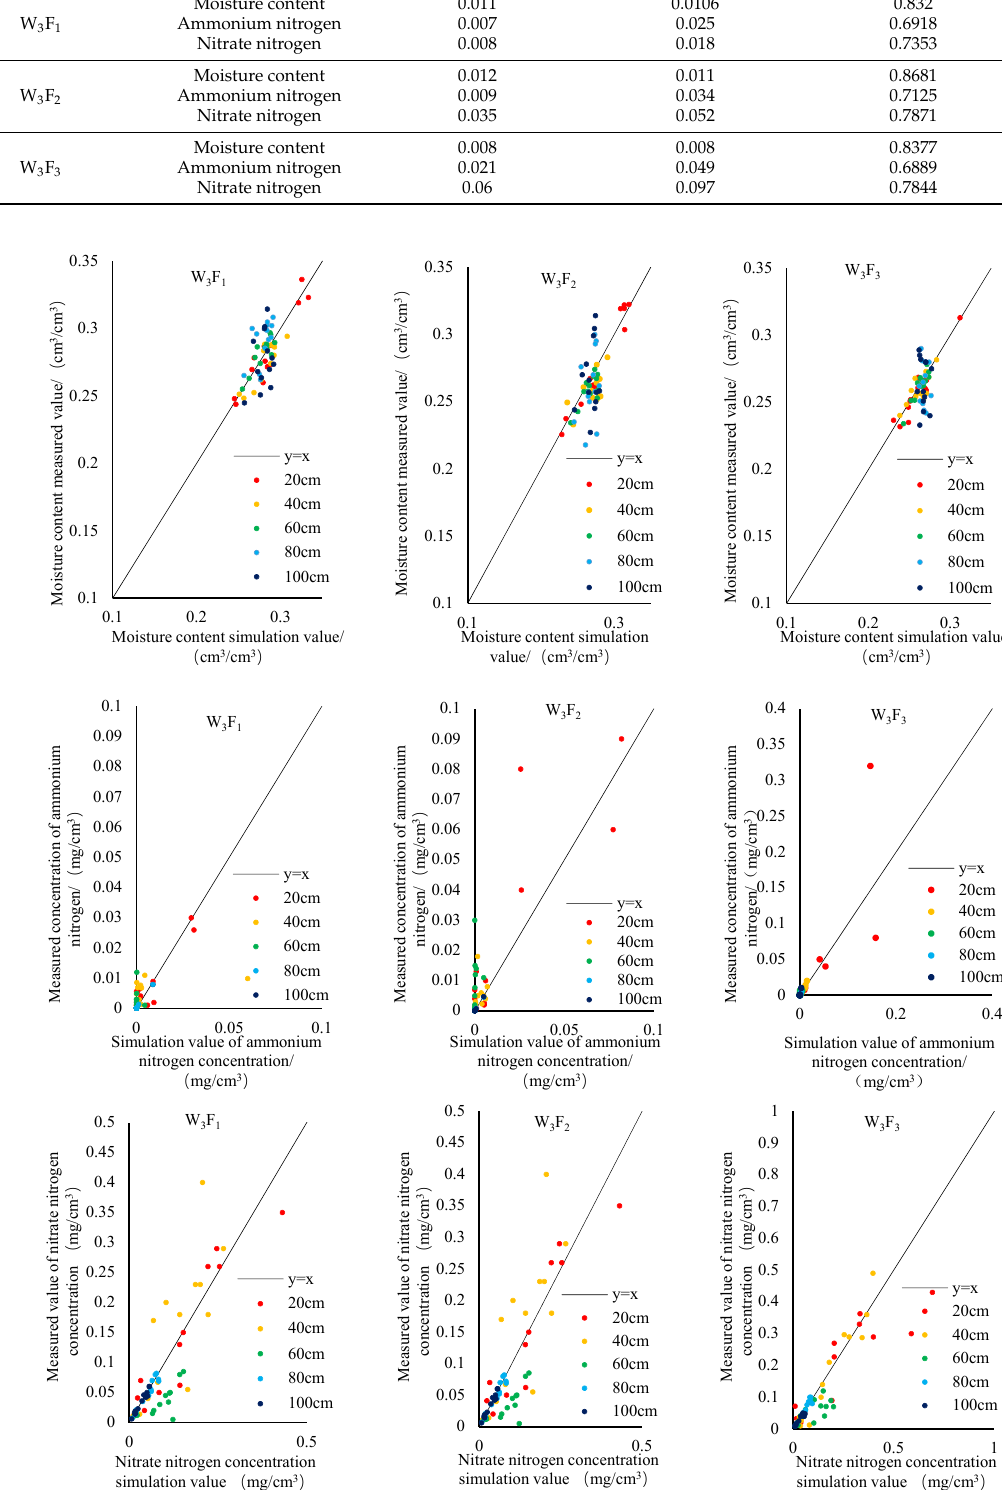
Table 6. Model accuracy was greatest for soil volumetric water content, with R 2 in the horizontal direction > 0.83 and R 2 in the vertical direction > 0.81. The MAE for predicted ammonium nitrogen compared with the measured value was 0.007–0.021 in the horizontal direction and 0.003–0.008 in the vertical direction. The RMSE was 0.025–0.049 in the hori- zontal direction and 0.003–0.023 in the vertical direction. However, R 2 was >0.68 due to the low concentration of ammonium nitrogen; only the ammonium nitrogen content had changed in surface samples, and the number of samples was small. The MAE for nitrate nitrogen content ranged from 0.008 to 0.06 in the horizontal direction and from 0.011 to 0.052 in the vertical direction. The RMSE ranged from 0.018 to 0.097 in the horizontal di- rection.